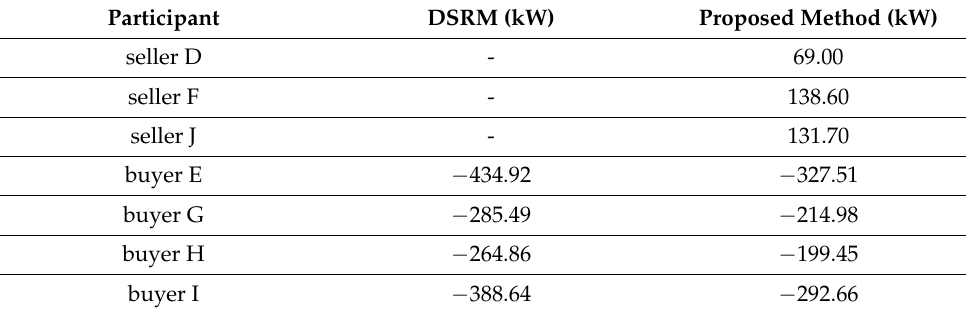
Table 10. Power adjustment based on the proposed method and DSRM.